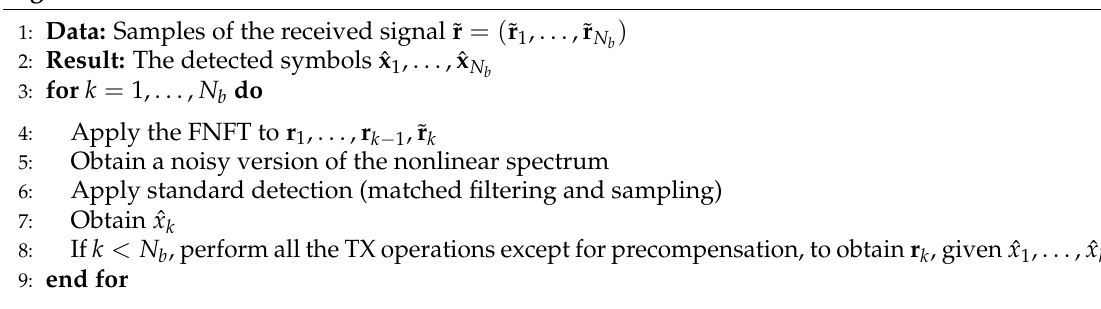
Algorithm 2 DF-FNFT detection